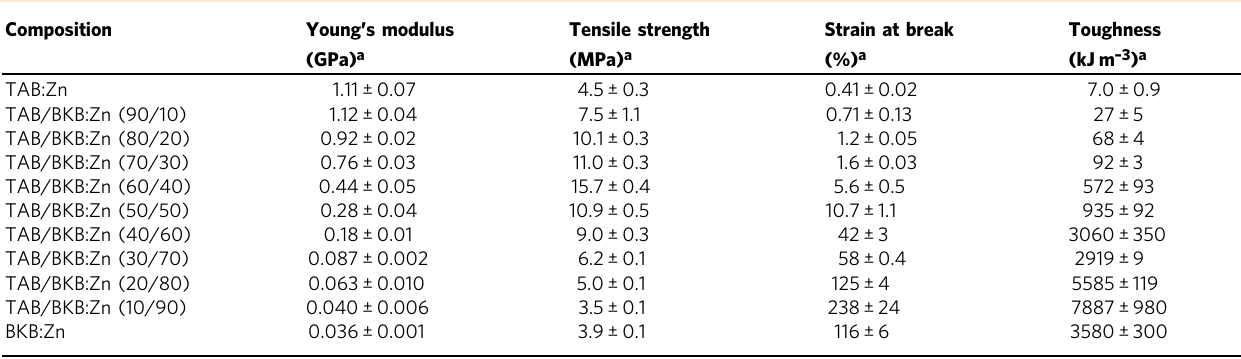
a Data represent averages of n = 3 – 7 individual measurements±standard deviation. Measured by stress – strain experiments at 25°C with a strain rate of 1% min − 1 . Mechanical properties as determined by uniaxial tensile tests with the MSPs TAB:Zn and BKB:Zn and the copolymers TAB/BKB:Zn with the indicated TAB/BKB weight ratio tensile strength are increased by factors of fi ve and two, respec- tively, while a high toughness is maintained. This behavior re fl ects the presence of a reinforcing TAB:Zn hard phase as a minority component. On the other end of the composition spectrum, the TAB:Zn majority phase dominates the stiffness, while the incorporation of BKB:Zn has the intended toughening effect. Strikingly, the stress – strain curves not only show increased extensibility, but the tensile strength continuously increases up to a BKB:Zn content of 40 wt%, at which point it is tripled in comparison to TAB:Zn. Copolymers in the middle of the com- positional spectrum display a tensile strength of 9 – 16 MPa and Young ’ s moduli in the range of 0.2 – 0.4 GPa (Table 1). These